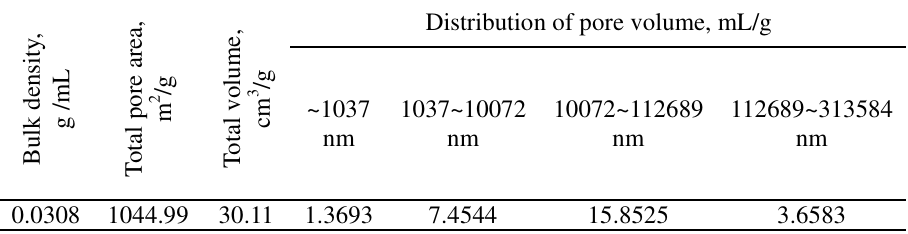
Table 1. Structural parameter of EG Distribution of pore volume,